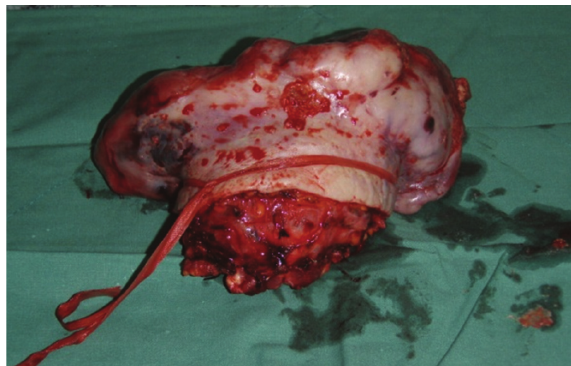
Figure 2: Tumour specimen after resection. Figure 4: Malignant solitary fibrous tumour demonstrating pat- ternless arrangement of spindle cells and areas with very high cellularity. The spindle cells have moderate cytological atypia, and three mitoses in mitotically active fields are evident (HE